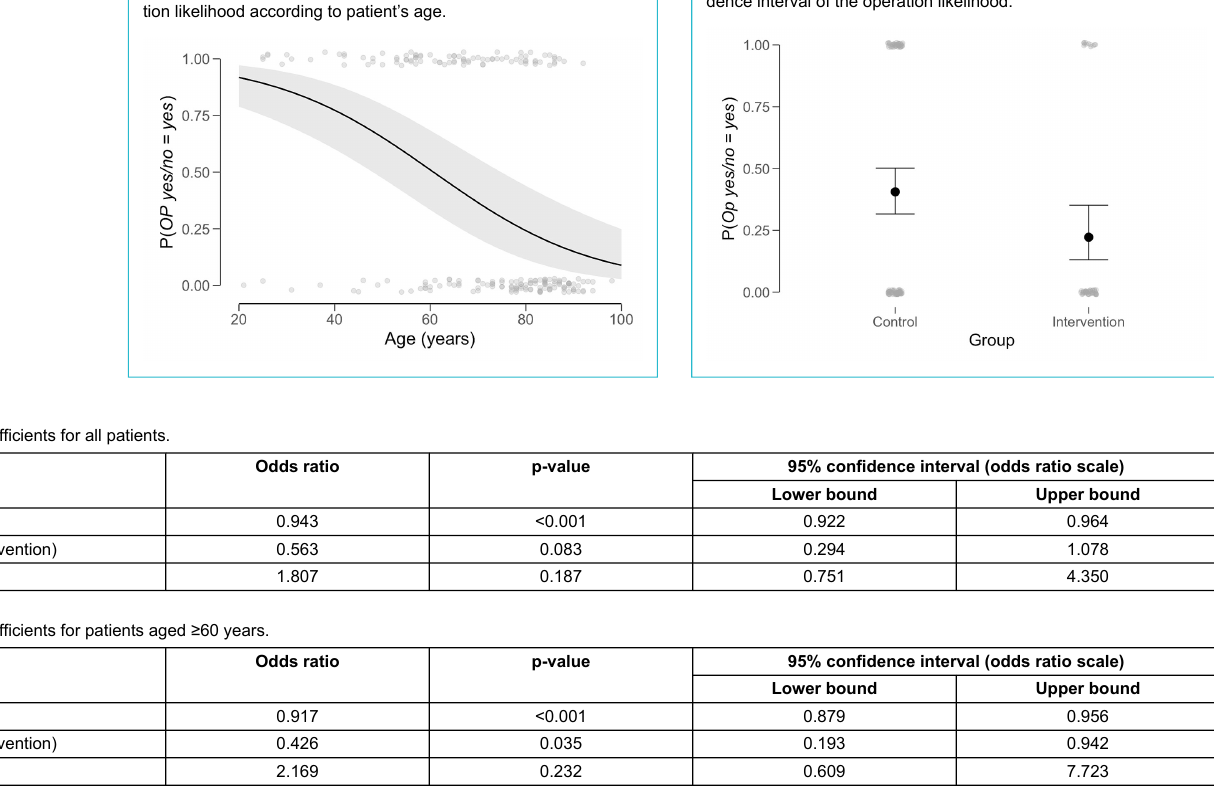
Figure 6: Correlation between treatment group and operation like- lihood in patients ≥60 years old.Op: Operation, Yes(1): Patients who underwent surgery after primarily being treated conservative- ly, No(0): completely conservatively treated patients, P: likelihood, grey dots: every dot represents one patient, black dot: represent the mean likelihood to get an operation, plot: shows the 95% confi- dence interval of the operation likelihood.